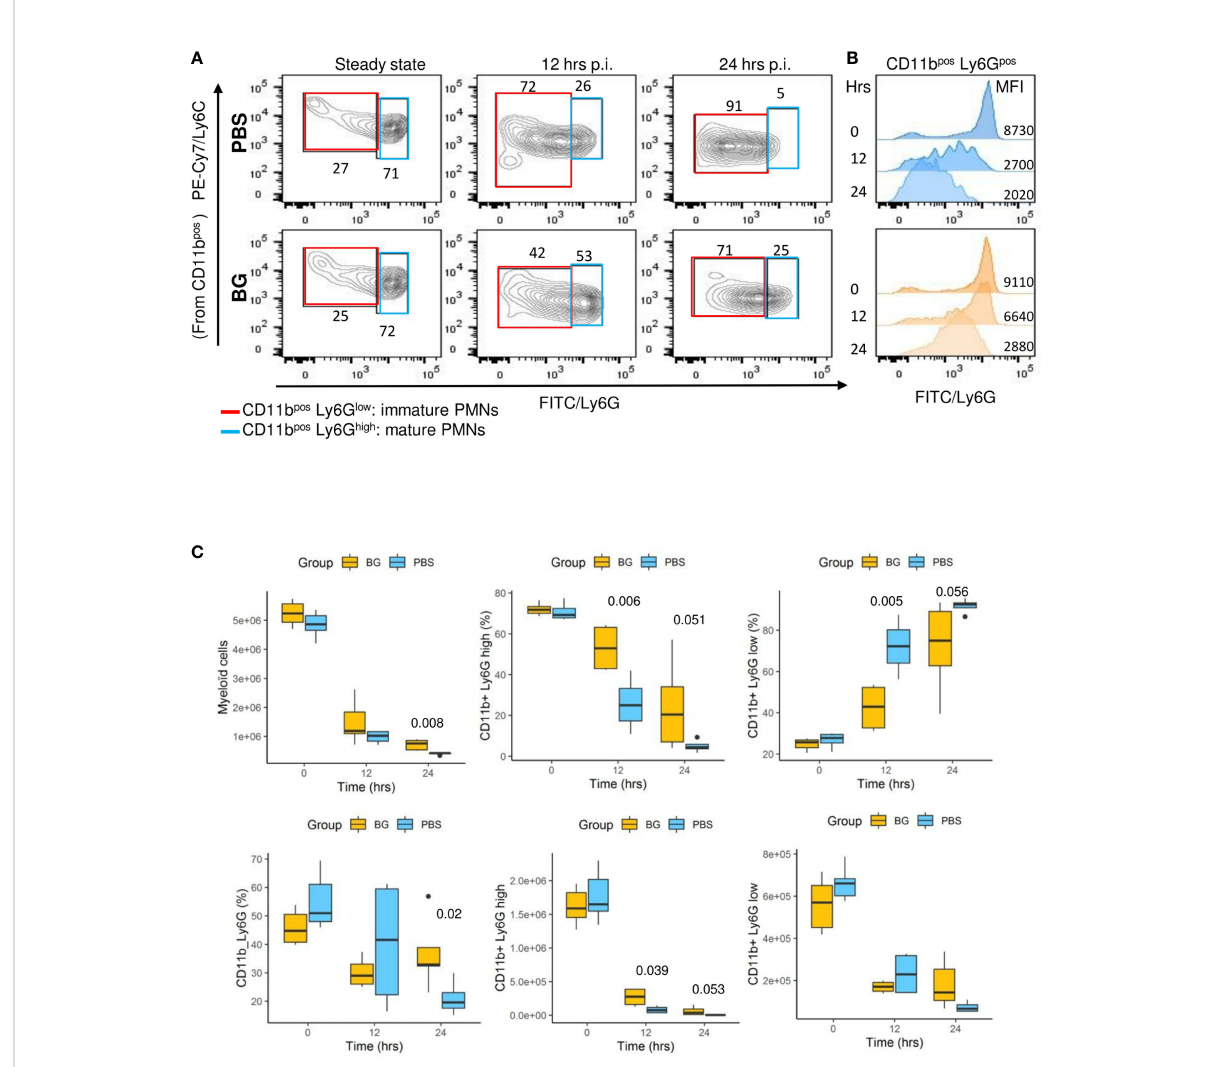
FIGURE 5 Neutrophil differentiation in bone marrow after oral supplementation and ( E ) coli challenge. (A) Flow-cytometry analysis of myeloid CD11 pos , Ly6G High , or Ly6G Low cell frequencies in bone marrow over time (the frequencies indicated are representative of the mean frequencies recorded for each group at each time point). (B) Flow-cytometry assessment of Ly6G mean fl uorescence intensity among CD11b pos cells. (C) Flow- cytometry determination of CD11b pos , CD11b pos Ly6G high , or Ly6G low frequencies and numbers in bone marrow at steady state and after E . coli challenge. Statistical analysis was performed using the Welch t-test and signi fi cant p values are indicated. The number of mice and experiments are detailed in Supplementary Table